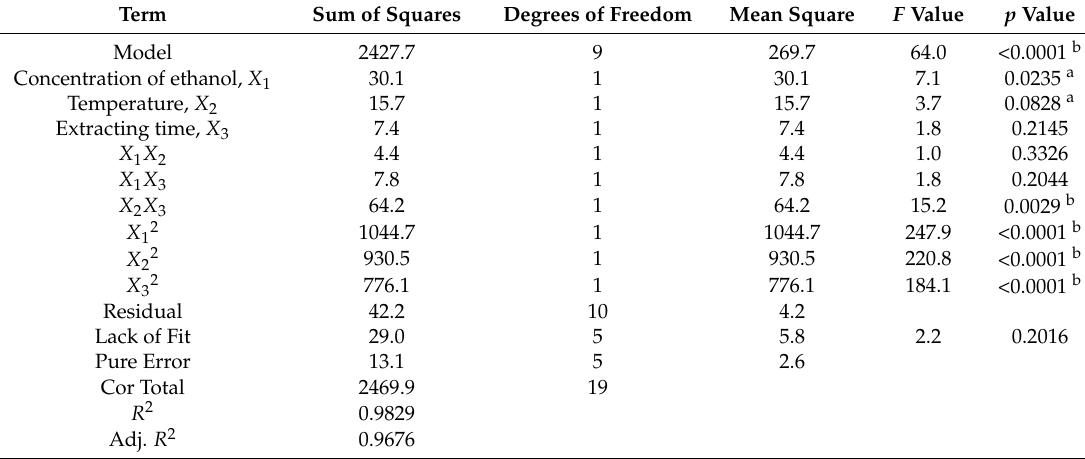
Table 3. ANOVA for response surface